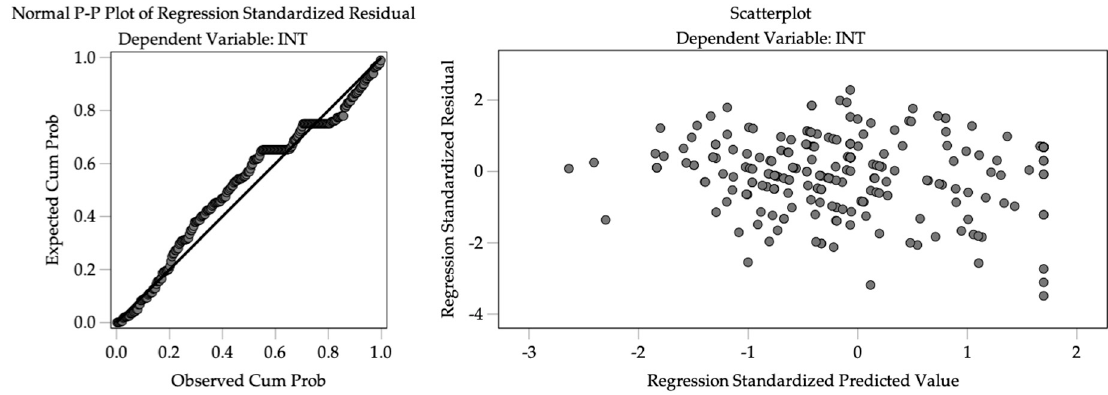
Figure 2. Normal P–P plot and scatter plot. 347